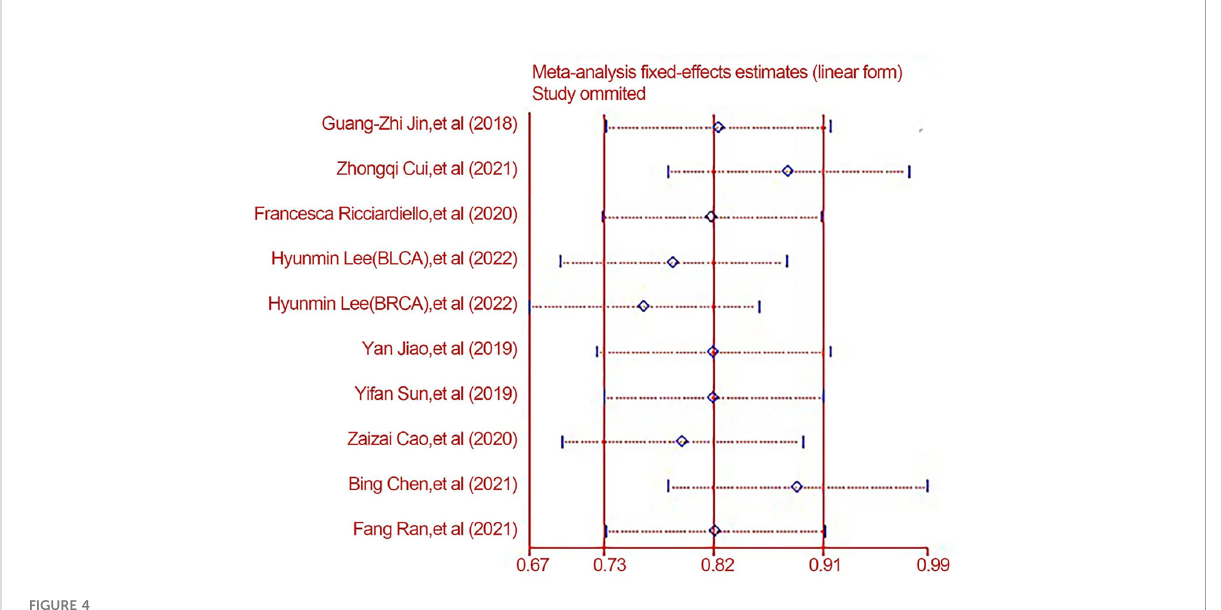
FIGURE 4 The Overall Sensitivity analysis between different groups.